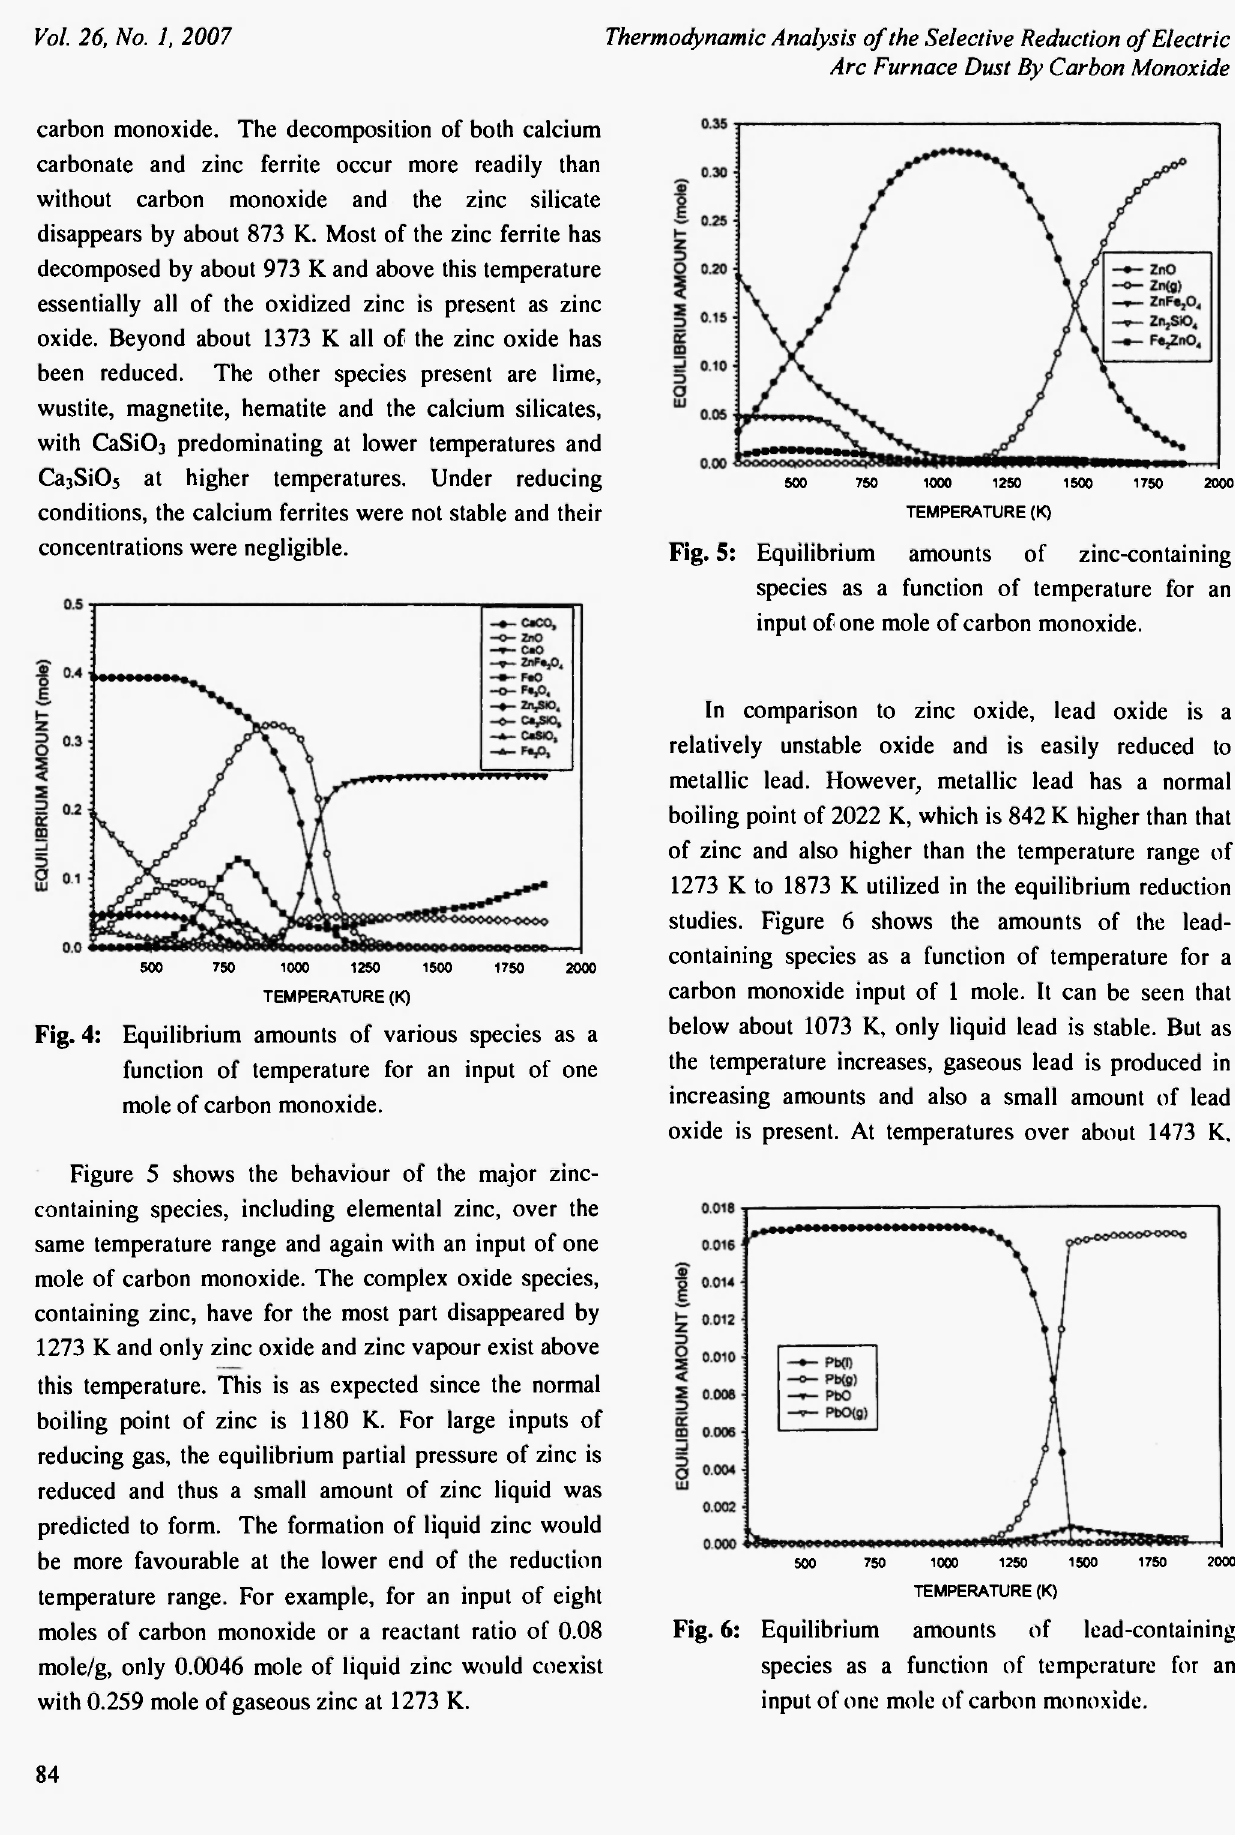
Fig. 6: Equilibrium amounts of lead-containing species as a function of temperature for an input of one mole of carbon